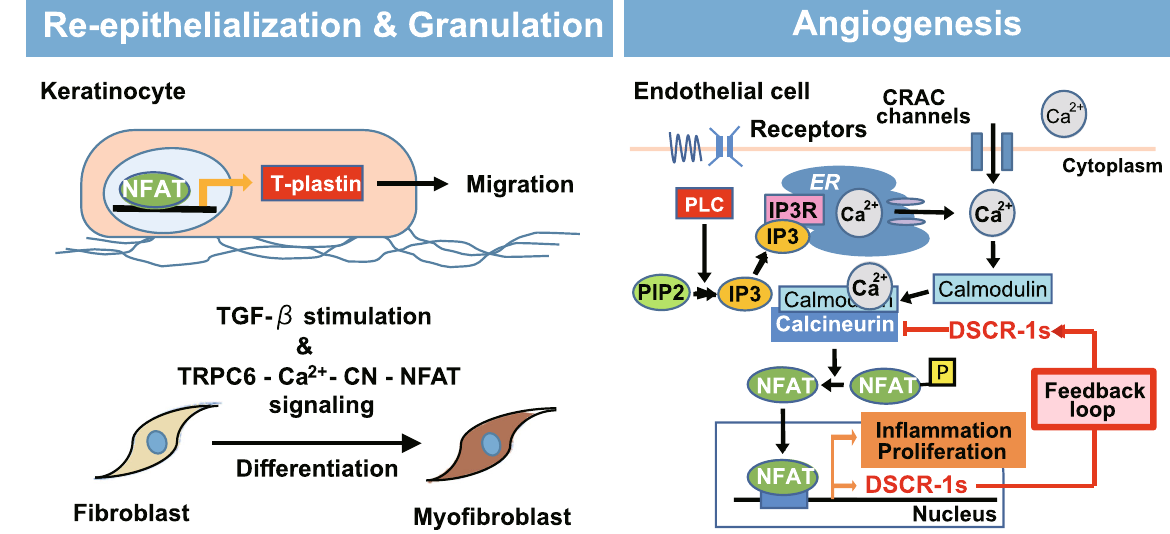
Fig. 1 Schematic illustration of NFAT-mediated wound healing processes. Wound healing steps are summarized following the orders of coagulation, inflammation, and the subsequent re-epithelization, granulation, and angiogenesis. CRAC; calcium release-activated calcium, PLC; phospholipase C, PIP2; phosphatidylinositol 4,5-bisphosphate, IP3; inositol trisphosphate, ER; endoplasmic